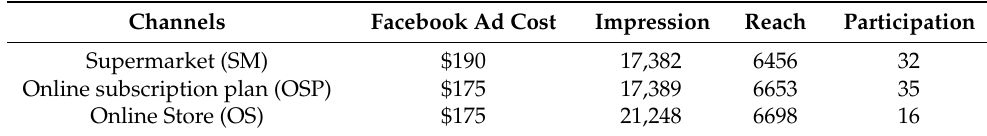
Table 1. Participation by the channel options.